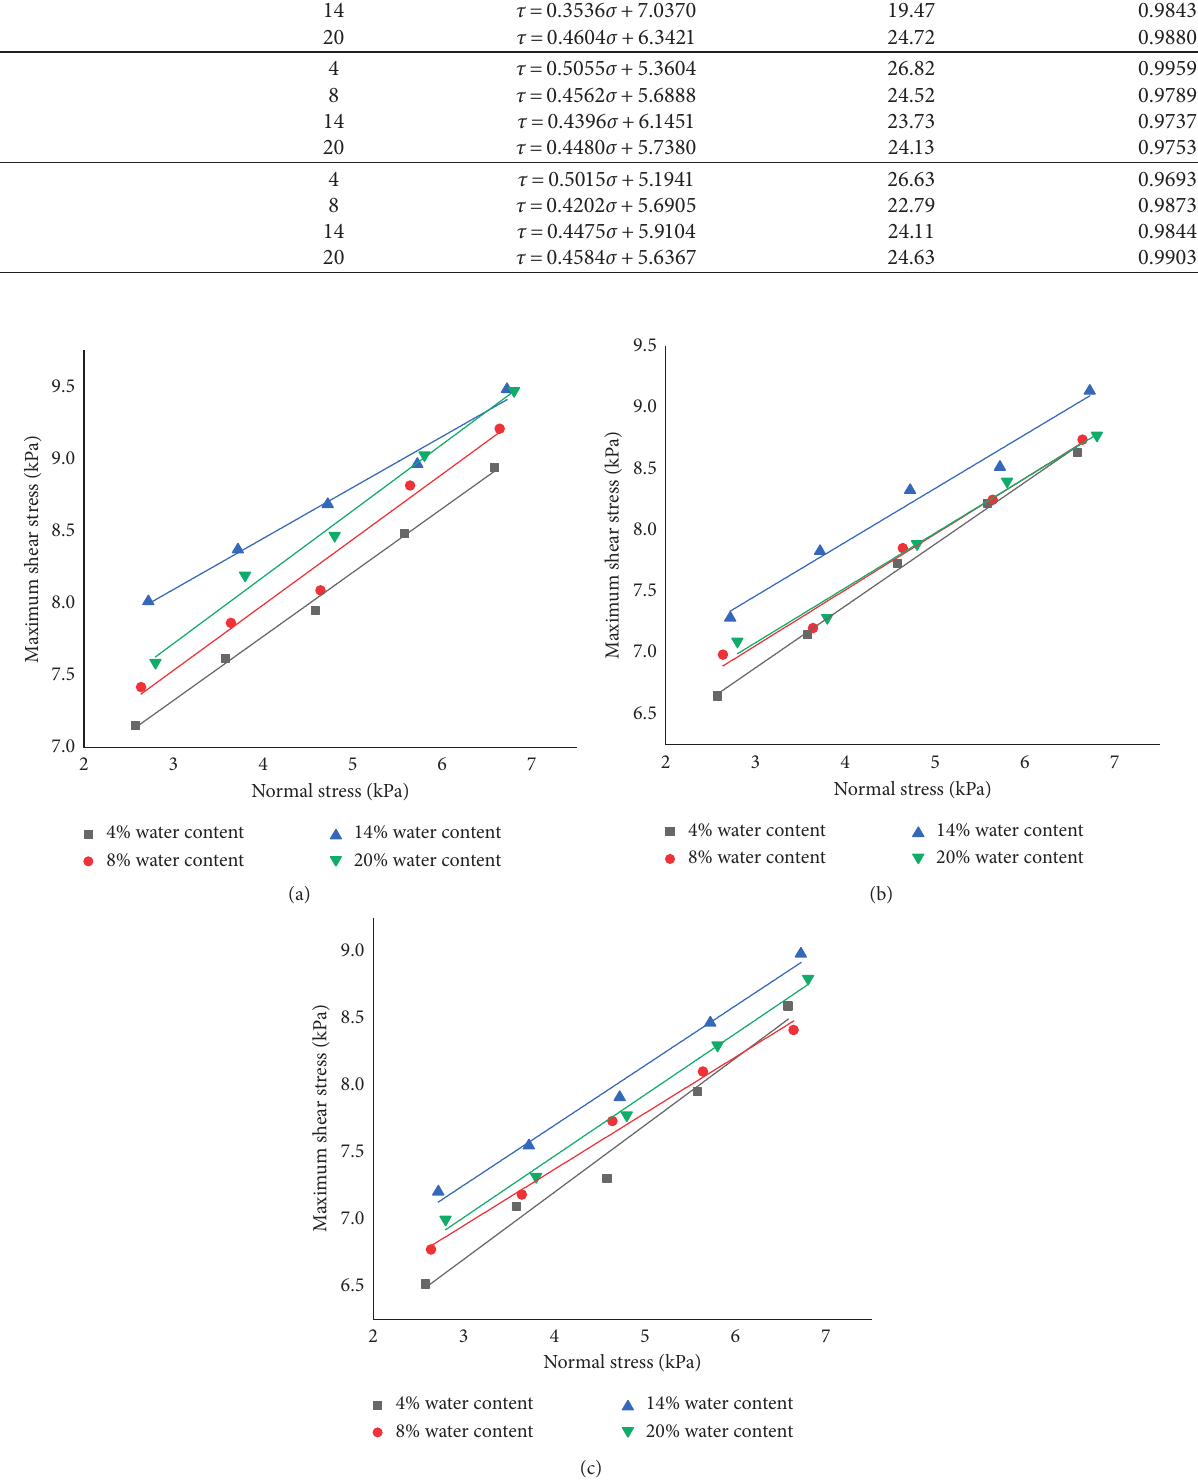
Figure 11: The maximum shear stress-normal stress curve for different dry-wet cycles with different water content. (a) 0 times. (b) 7 times. (c) 30 times.